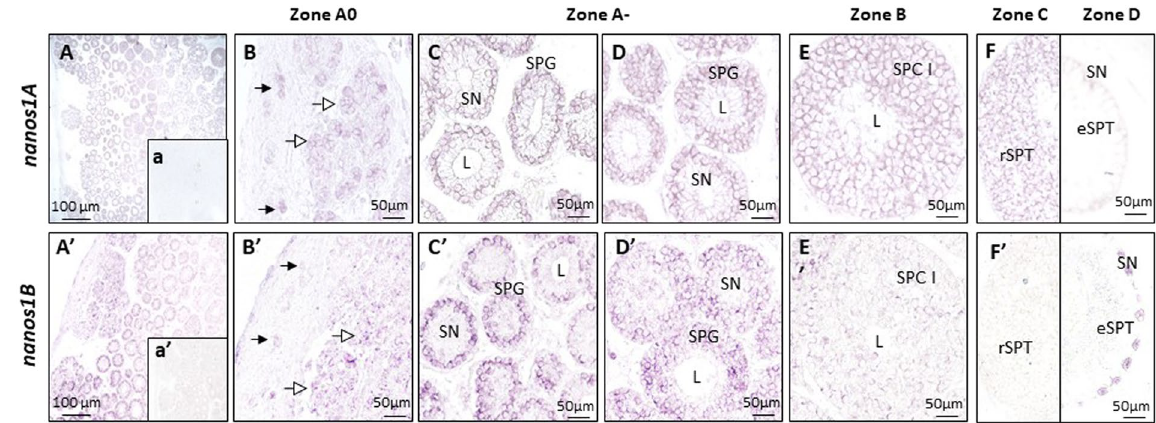
Figure 5. Different but both germ cell-specific expressions of nanos1A and nanos1B in dogfish testis. The cellular distribution of nanos1 mRNAs was evaluated by in situ hybridization on dogfish testicular sections with antisense digoxigenin-conjugated riboprobes directed against nanos1A ( A – F ) or nanos1B transcripts (A’–F’). a and a’ represent sense riboprobes ISH for nanos1A and nanos1B respectively. The nanos1A transcripts were detected in the potential SSC (filled arrow) and in undifferentiated spermatogonia (open arrow) of the zone A0 ( B ), in the spermatogonia (SPG) of zone A- ( C , D ) as well as in the primary spermatocytes (SPCI) of the zone B ( E ) and in the round spermatids (rSPT) of the zone C (F left panel). No signal was observed in the elongated spermatids (eSPT) of the zone D (F right panel) nor in the Sertoli cells (their nuclei are indicated by SN). The nanos1B transcripts were mainly detected in the potential SSC (filled arrow), the undifferentiated spermatogonia (open arrow) of zone A0 (B’) and in spermatogonia (SPG) of zone A- (C’,D’). A marked decrease in nanos1B expression was observed in the primary spermatocytes (SPCI) of zone B (E’) and no transcript was present in the germ cells of zone C (F’ left panel) and zone D (F’ right panel). Aspecific labelling was observed in Sertoli cells nuclei of zone D using nanos1B riboprobes (F’ right panel). L: lumen of the cyst; A, A’: overview of zone A of